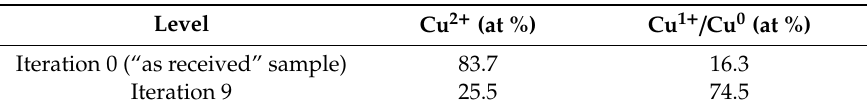
Table 9. Cu oxide ratios.